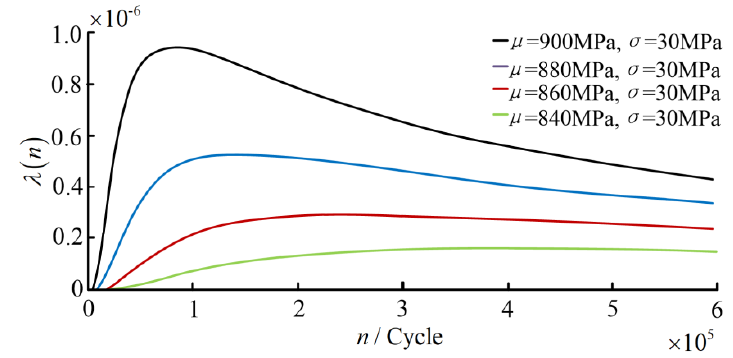
Figure 10. Failure rate affected by mean stress.